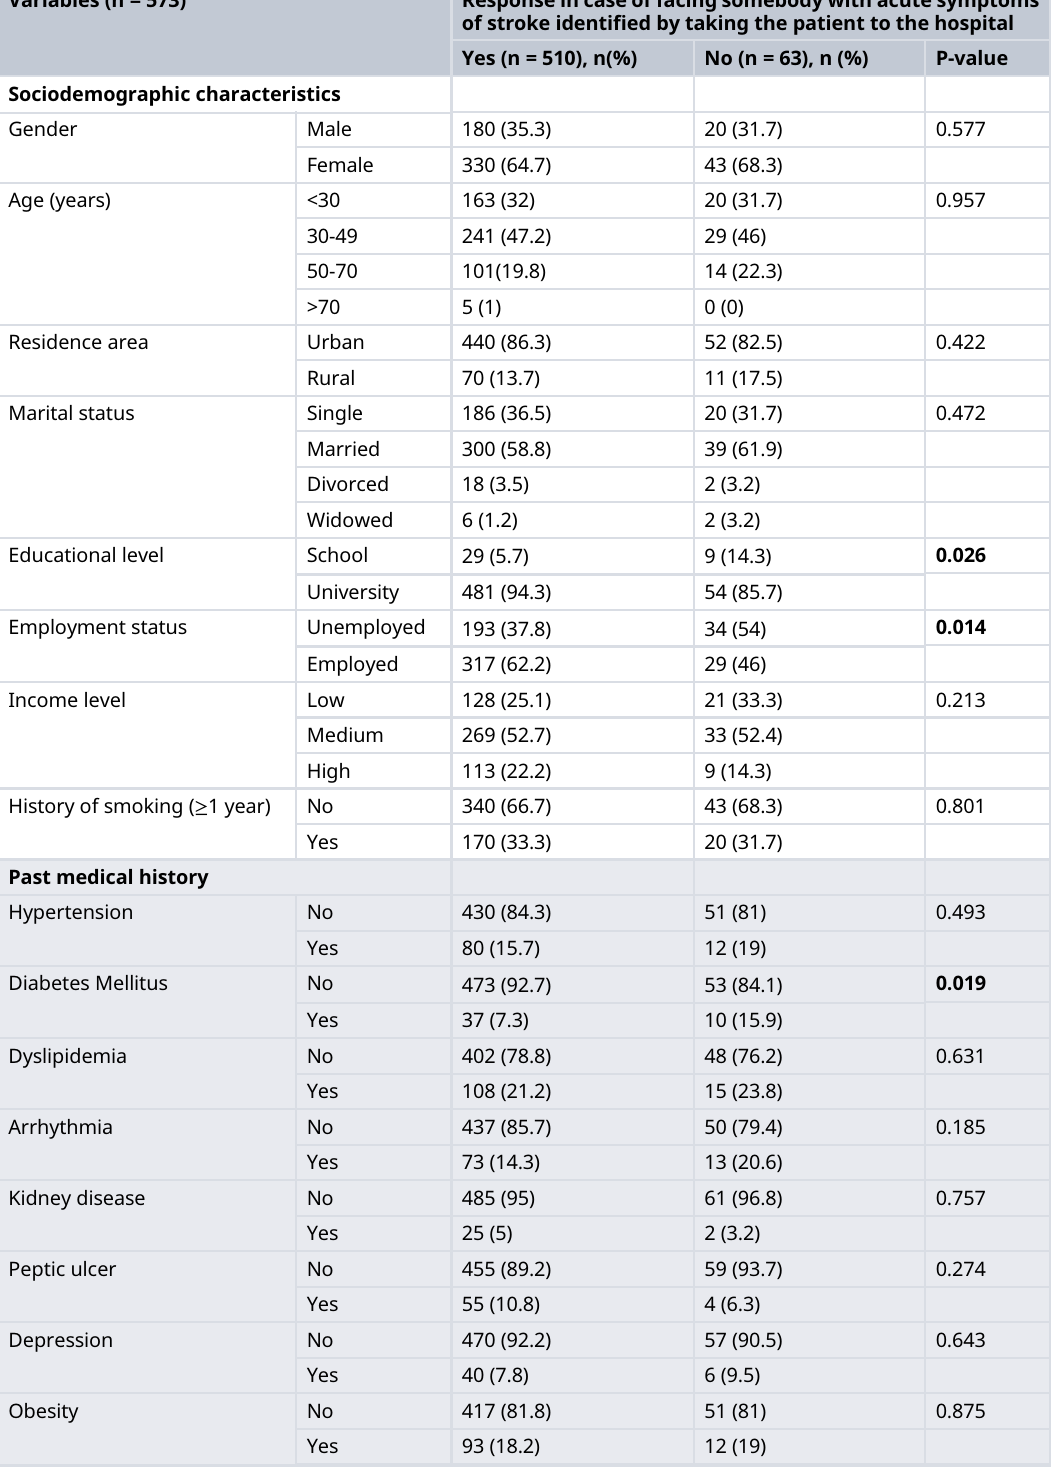
Table 4. Association of response in case of facing somebody with acute symptoms of a stroke (identified by taking the patient to the hospital) and with sociodemographic characteristics, aand past medical history Variables (n =